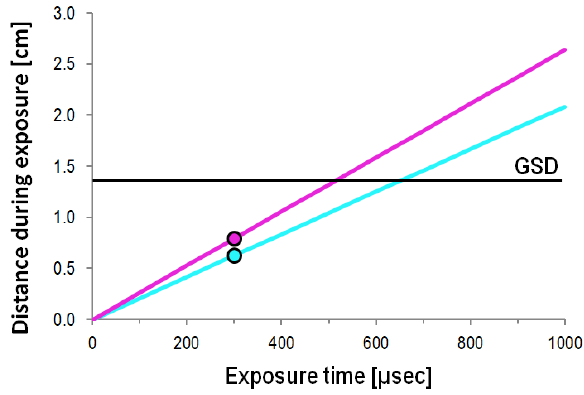
Figure 3. Relation between distance during exposure at 75km/h (cyan) and 95km/h (magenta) at different exposure times.